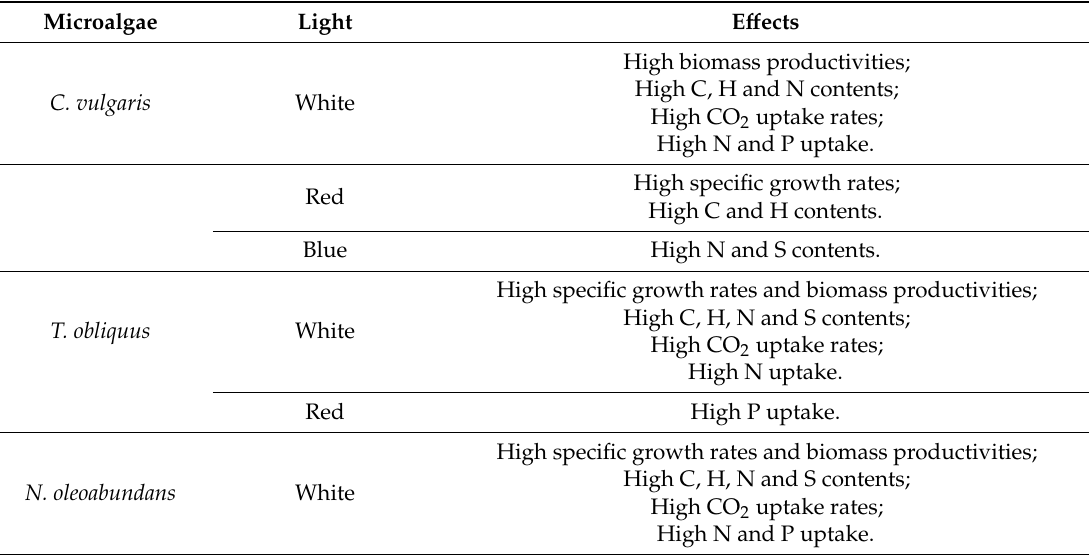
Table 5. Summary of the influence of light wavelengths on studied